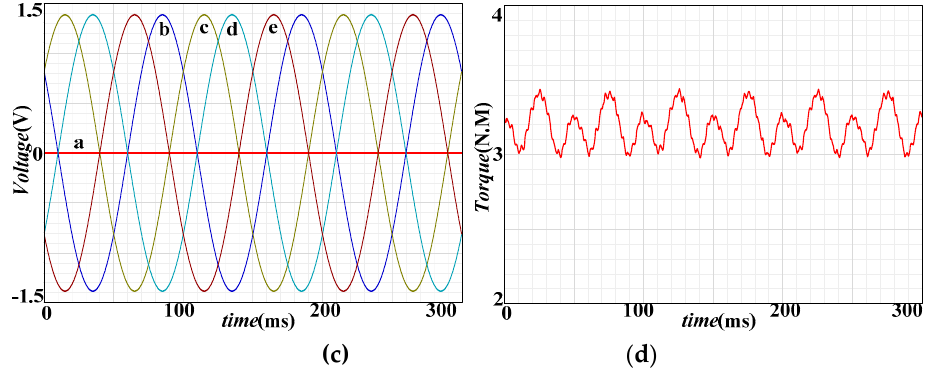
Figure 9. Fault-tolerant current and torque waveforms under single open-phase condition: ( a ) current of MCL;( b ) torque of MCL;( c ) current of MTO;( d ) torque of MTO.